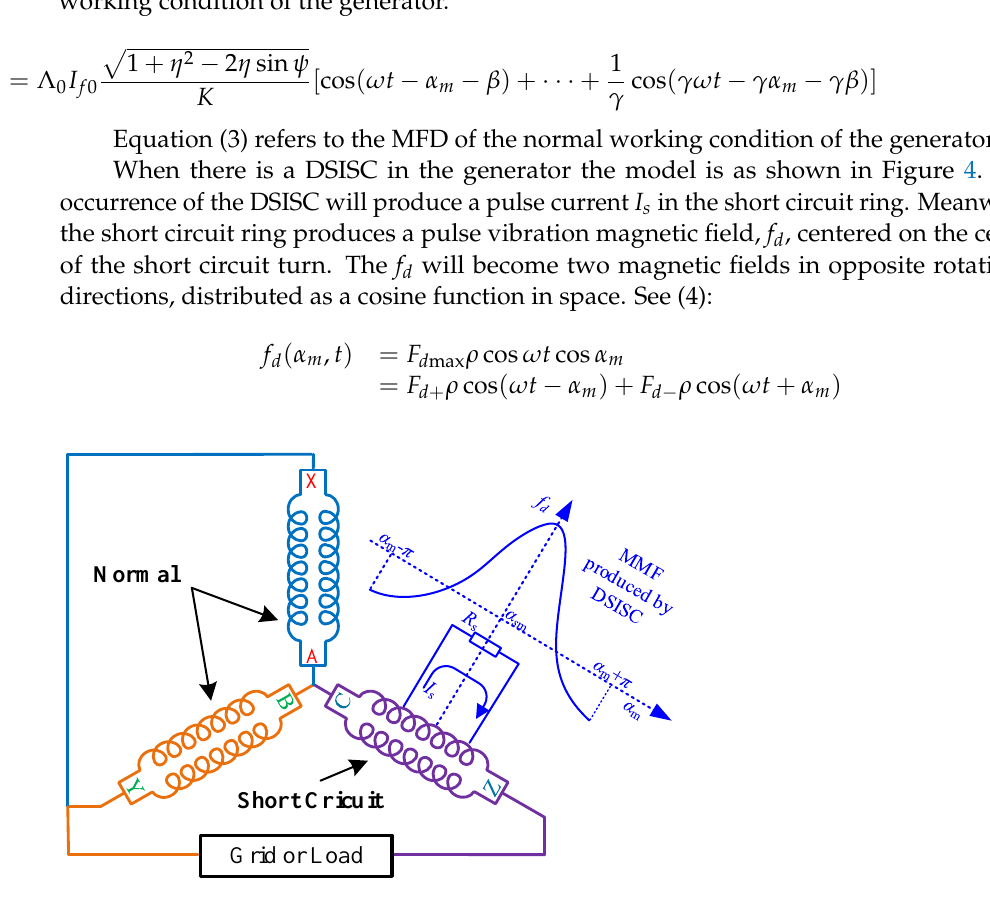
Figure 4. Stator interturn short-circuit model.